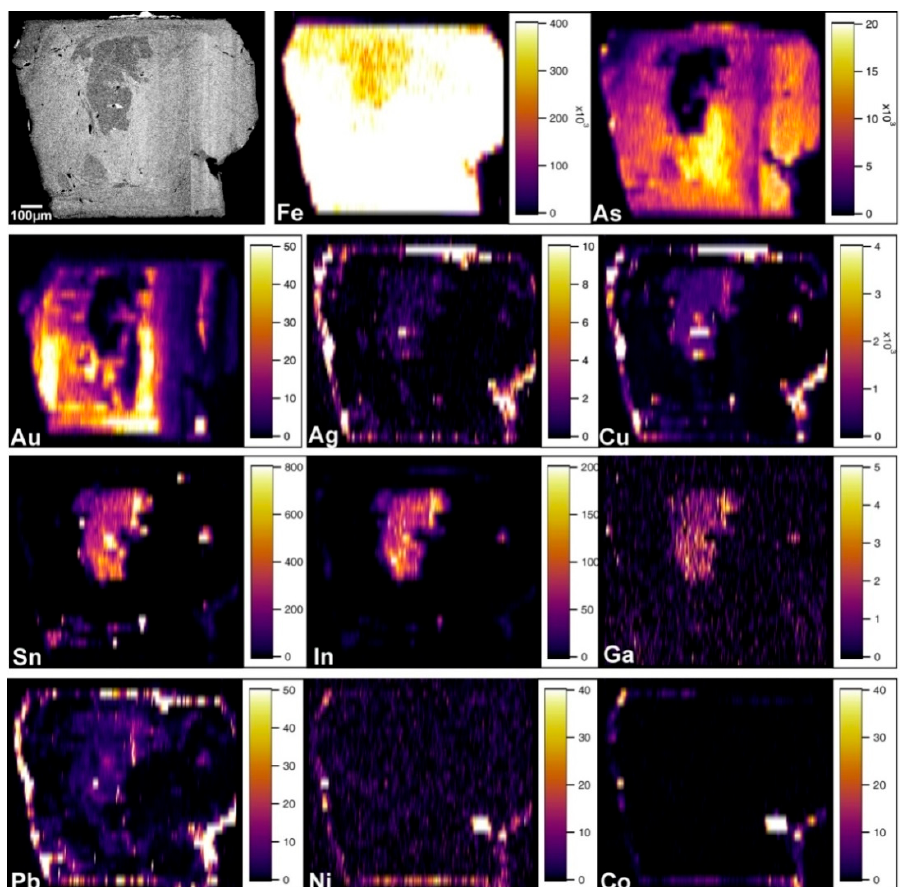
Figure 12. The pyrite crystal BSE image (top left) and the element distribution maps; semi- quantitative analysis, scales in ppm.